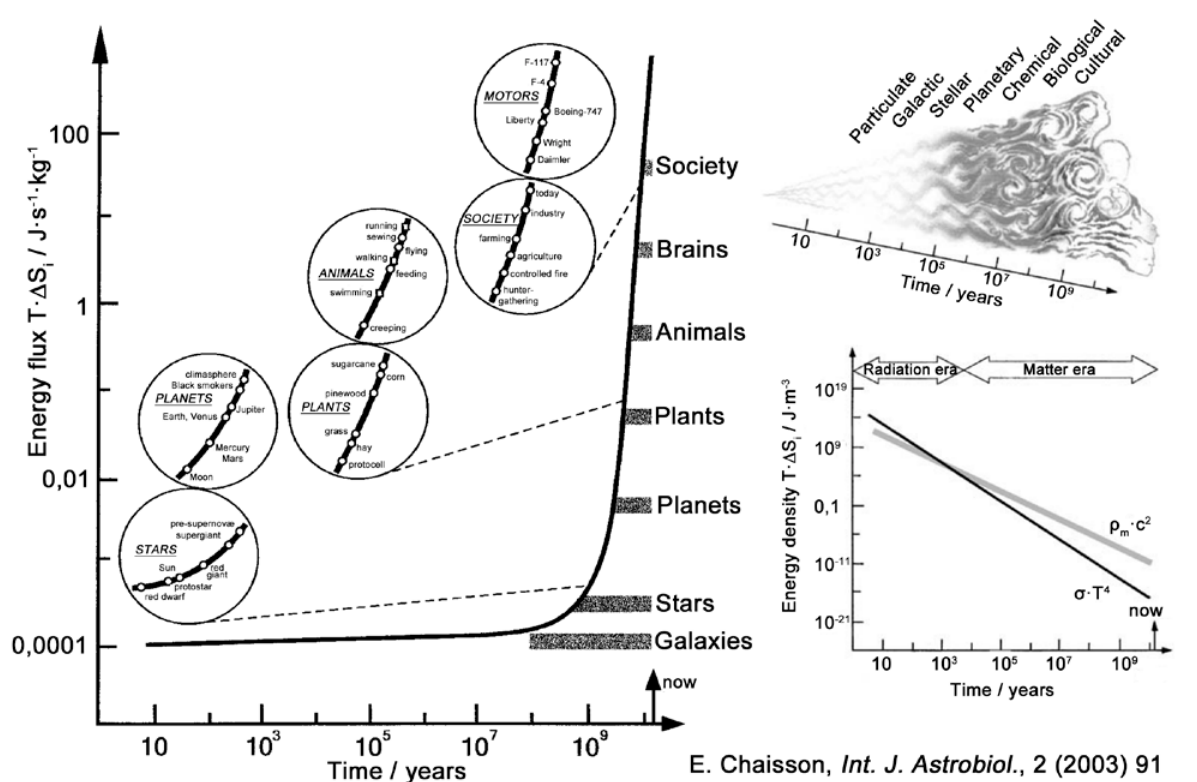
Figure 3. The exponential rise in complexity as a function of irreversible energy flux (left). Top-right: arrow of time and major evolutionary phases that have produced the visible universe. Bottom-right: the crossover between evolution in time of radiation energy density (Stefan- Boltzmann σ·T 4 law) and matter energy density (ρm·c 2 ) leading to neutral atoms formation some ≈ 105 years after the big-bang. Adapted from Eric J. Chaisson’s work.